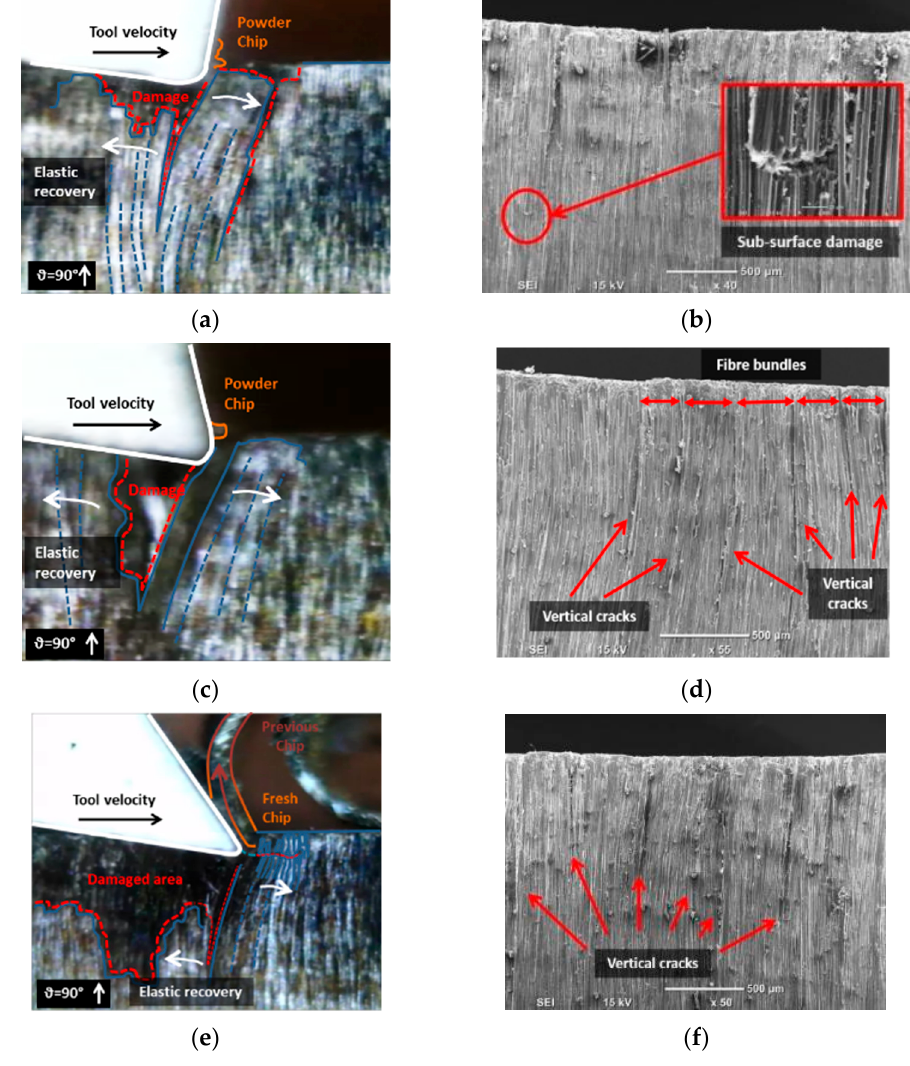
Figure 11. Chip formation at fibre orientation 90° and tool rake angle ( a , b ) − 10°; ( c , d ) 10 °; ( e , f ) 30°.